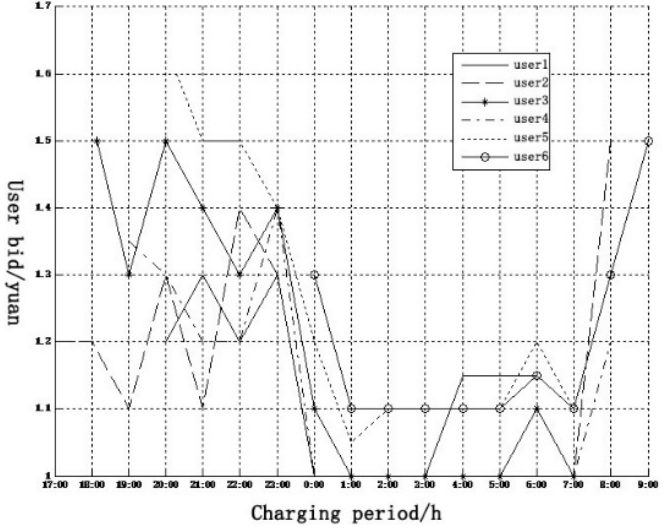
Figure 3. User points bid graph.